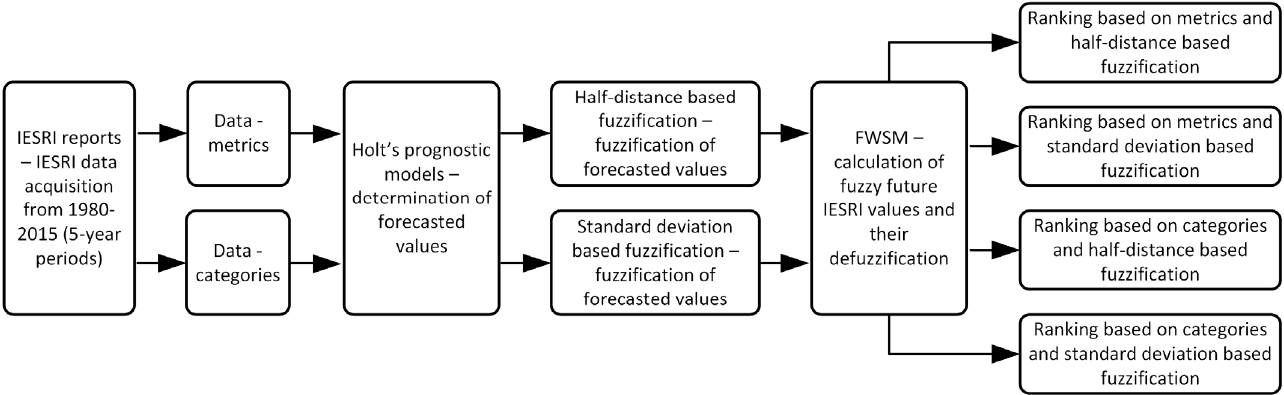
Figure 1. Scheme of the research procedure.